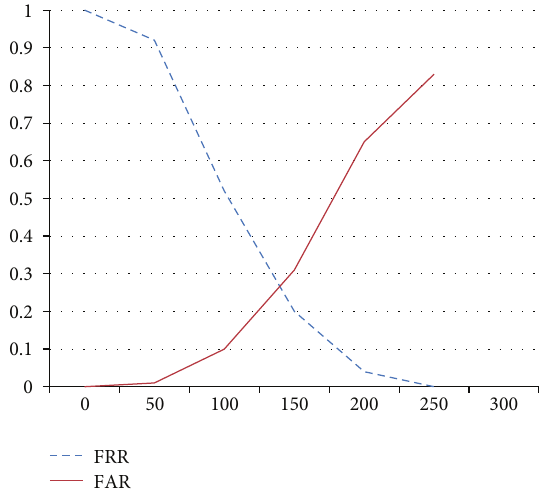
Figure 10: The FRR and FAR diagrams.